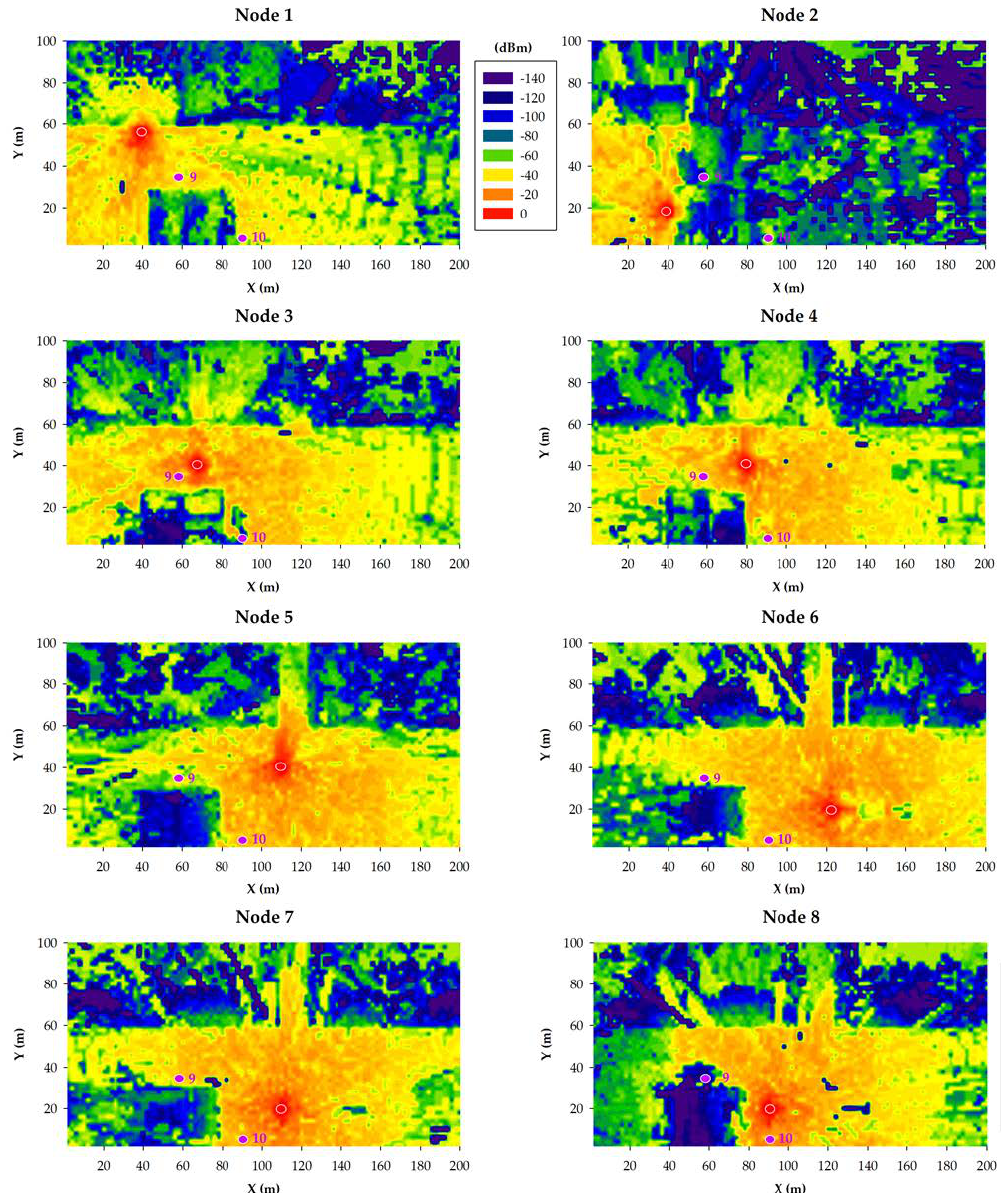
Figure 12. 433 MHz simulation results: RF power level distribution in a bi-dimensional plane on the ground